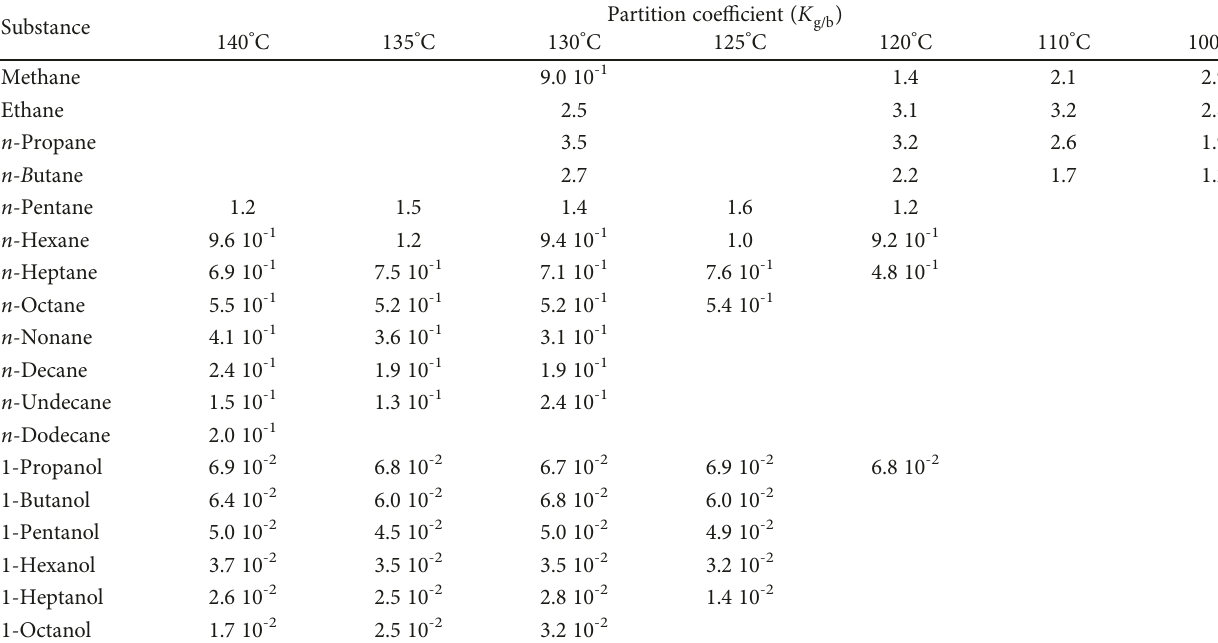
Table 3: Experimentally determined partition coe ffi cients K